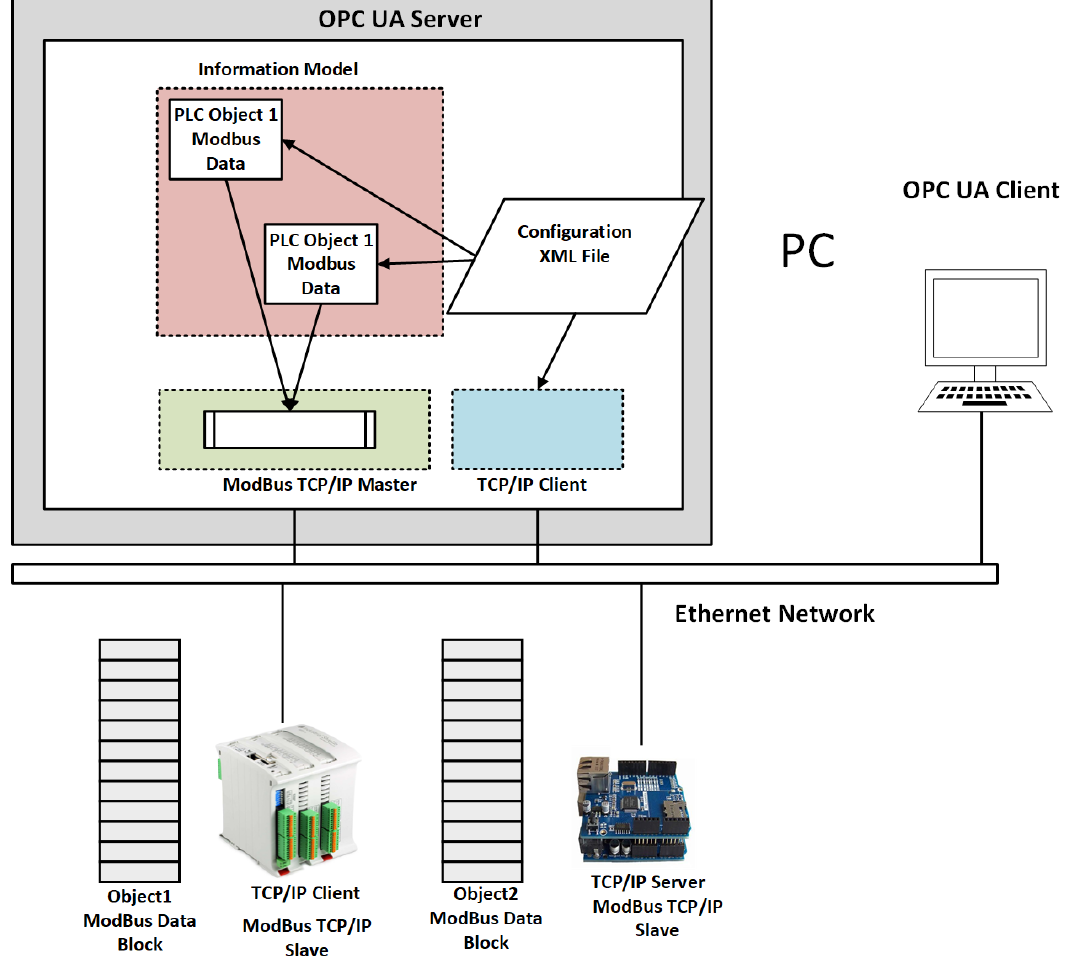
Figure 5. Architecture of the system prepared for the case study that includes the OPC UA server, the OPC UA client, the M-DUINO PLC and the Arduino ONE.